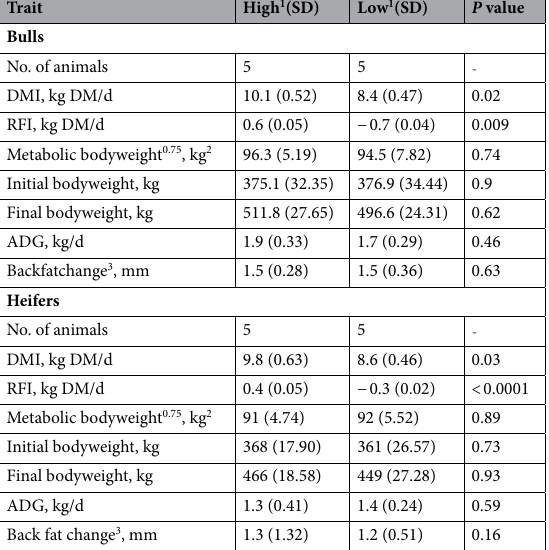
Ensemble Gene ID Symbol Log 2 FC 1 adj. P -value